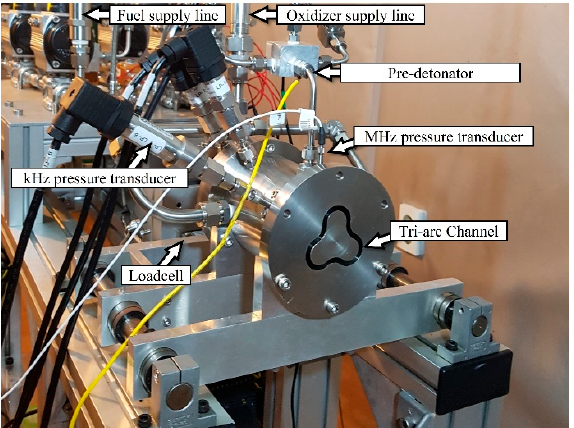
Figure 4. A picture of the experimental setup.